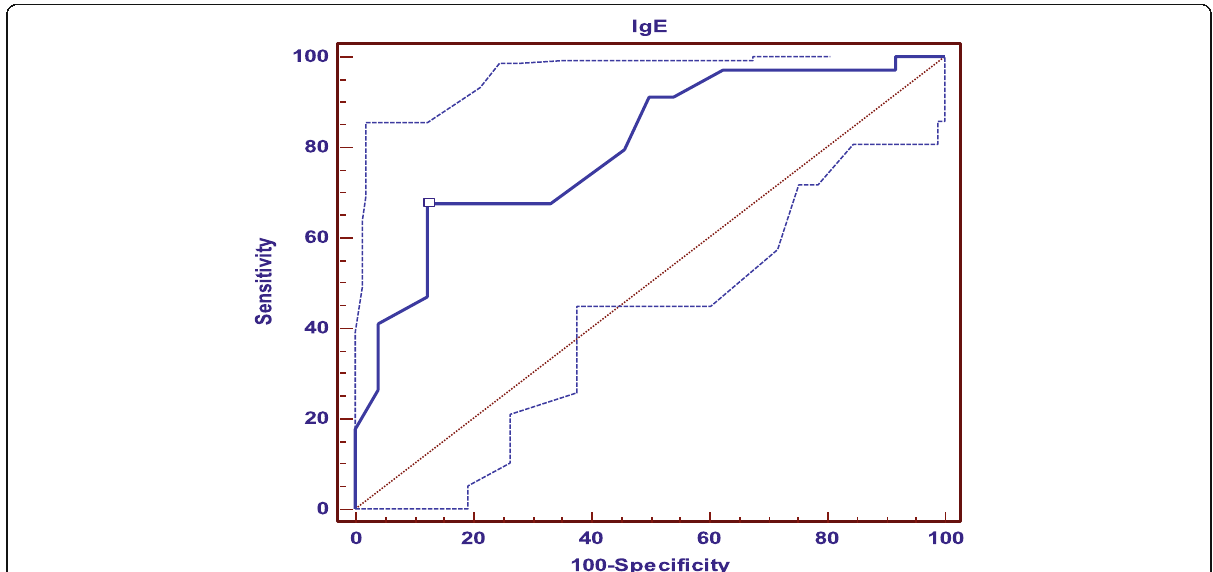
Fig. 2 ROC curve analysis of IgE to predict patient improvement with